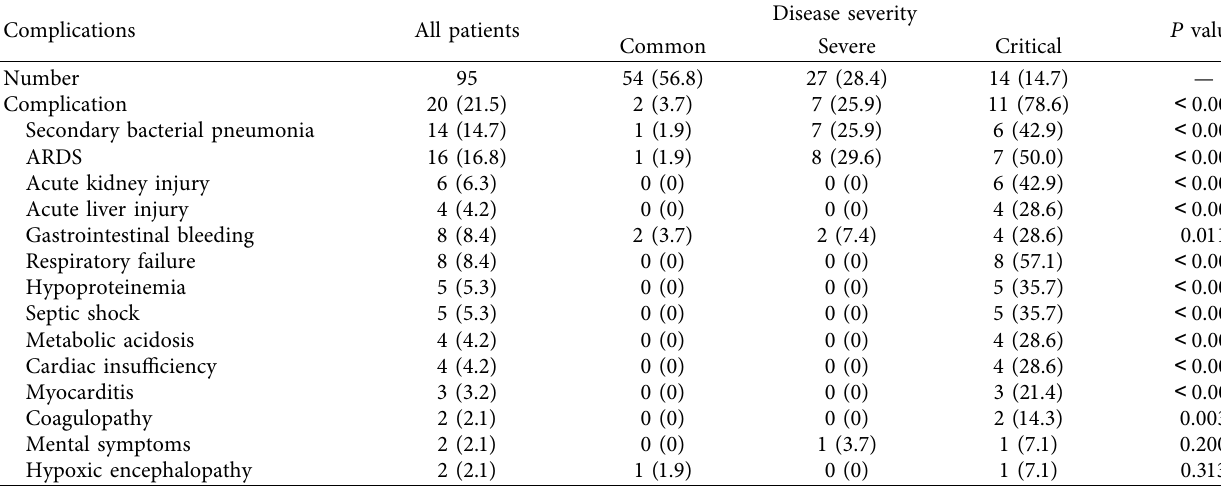
Table 3: Complications of COVID-19 patients.